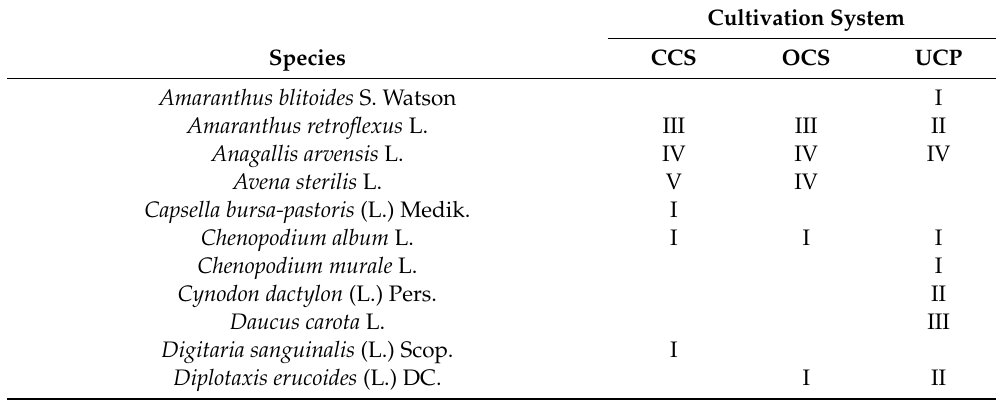
Table 2. Normalized frequency of occurrence [as expressed as presence classes (I: 0–20%; II: 20–40%;